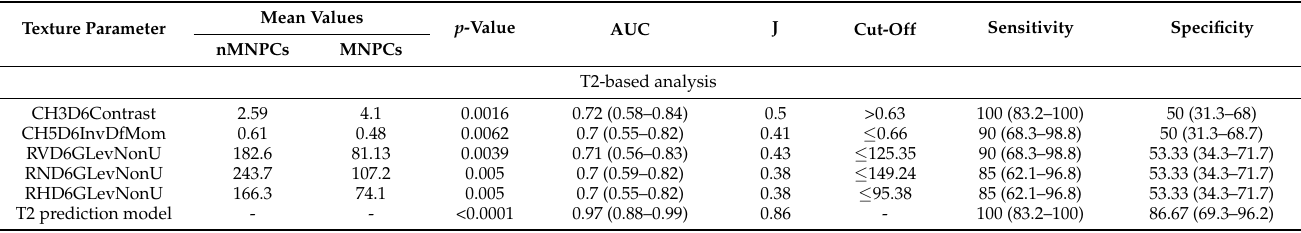
Table 5. Receiver-operating characteristics analysis results and the median values obtained by each